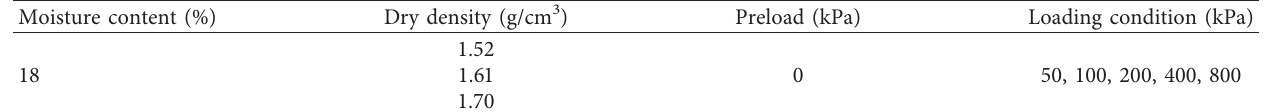
Table 4: Creep test schemes with different dry